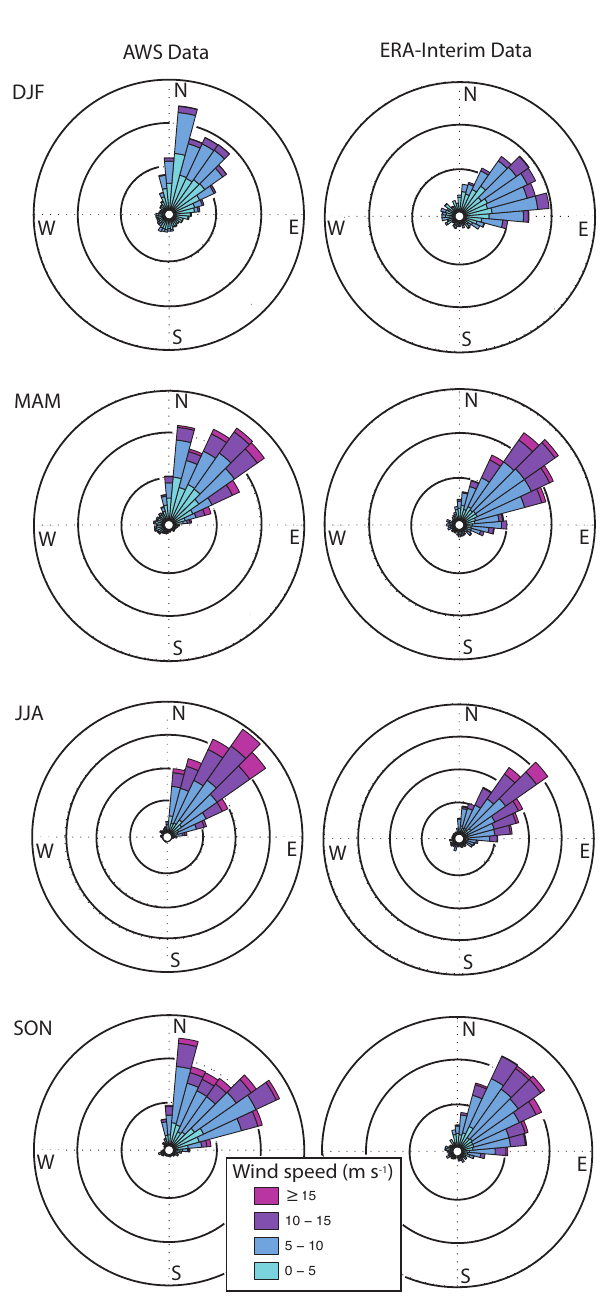
Figure 5. Automatic weather station (left) and ERA-Interim (right) surface wind speed and direction data by season from the WAIS Divide site. Wind rose plots show the frequency with which winds come from a given direction. Each dotted circle represents 5% of observations. True cardinal directions are